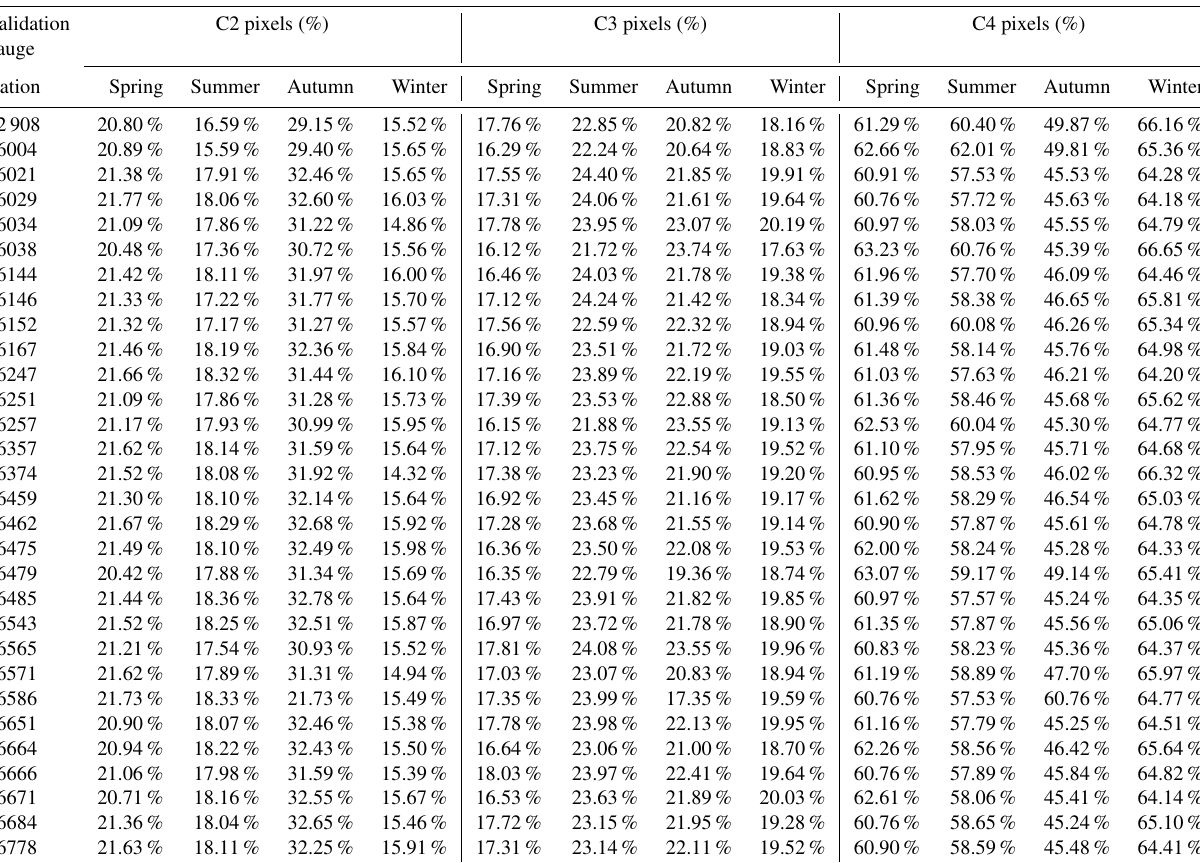
Table 3. The percentage of each class of pixel adjusted by each rule using the WHU-SGCC method within the Jinsha River basin.